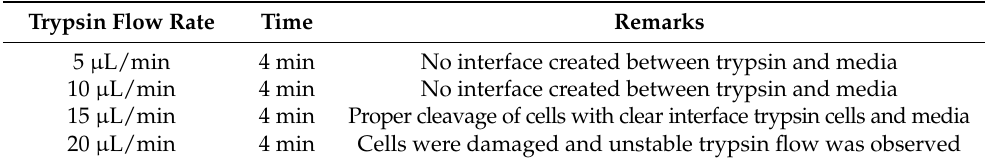
Table 3. Optimization of trypsin flow rate across silk film placed inside design 1 chip.